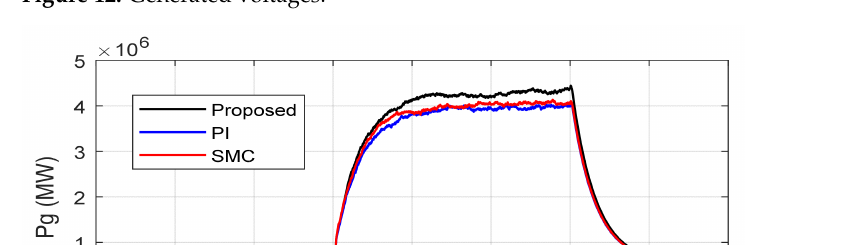
Figure 12. Generated voltages.